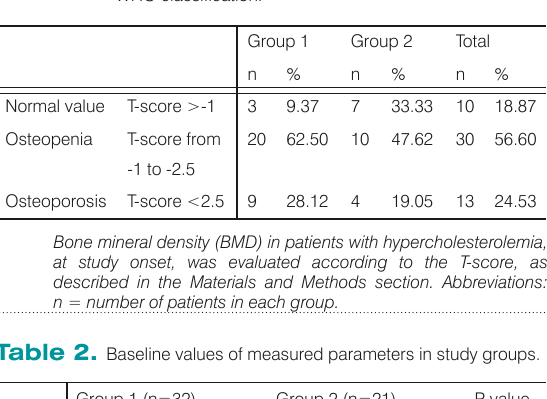
Table 1. T-score in patients with hypercholesterolemia according to WHO classification.